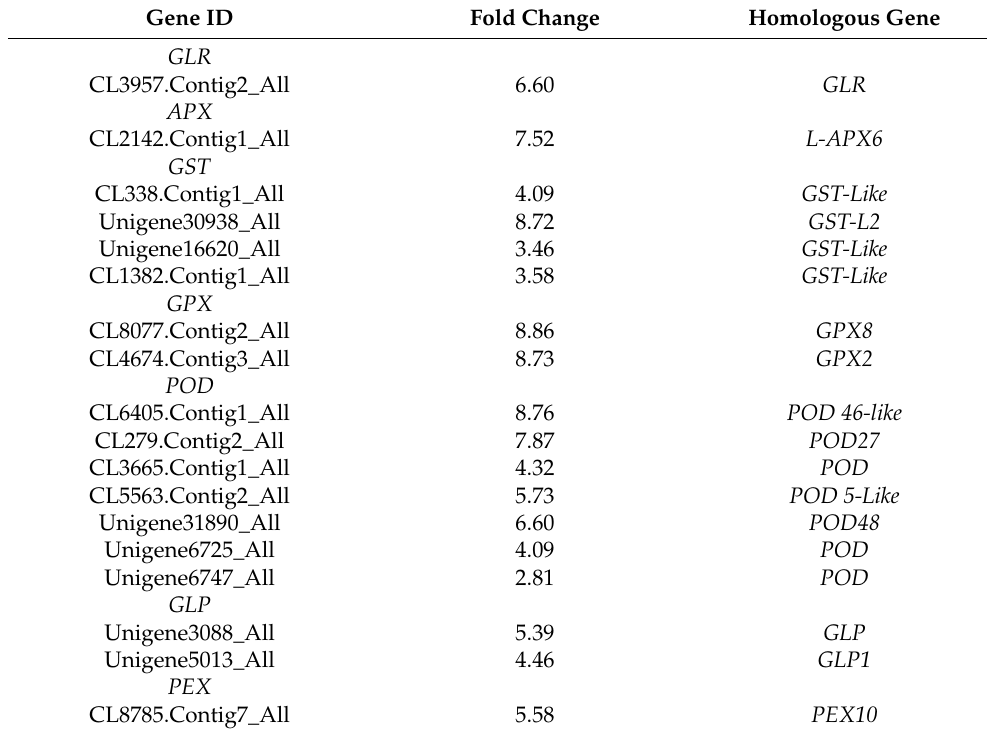
Table 2. The upregulated DEGs related to the ROS scavenging system in the leaves of A. canescens under 100 mM NaCl but not under the control condition for 24